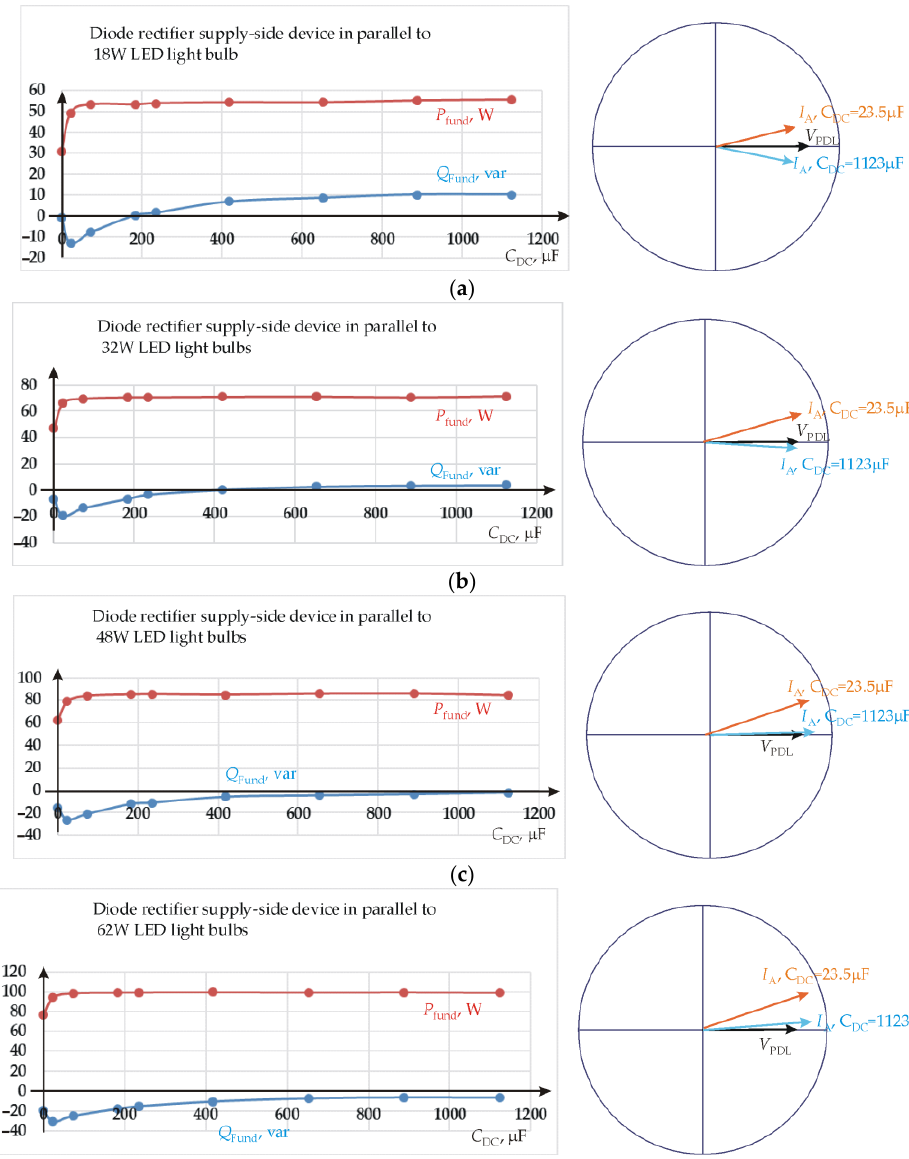
Figure 14. Active and reactive power provided or drawn out by LED light and diode rectifier supply-side devices as function of DC circuit capacity value: ( a ) 15 W LED light bulb, ( b ) 32 W light bulbs; ( c ) 48 W LED light bulbs; ( d ) 62 W LED light bulbs.